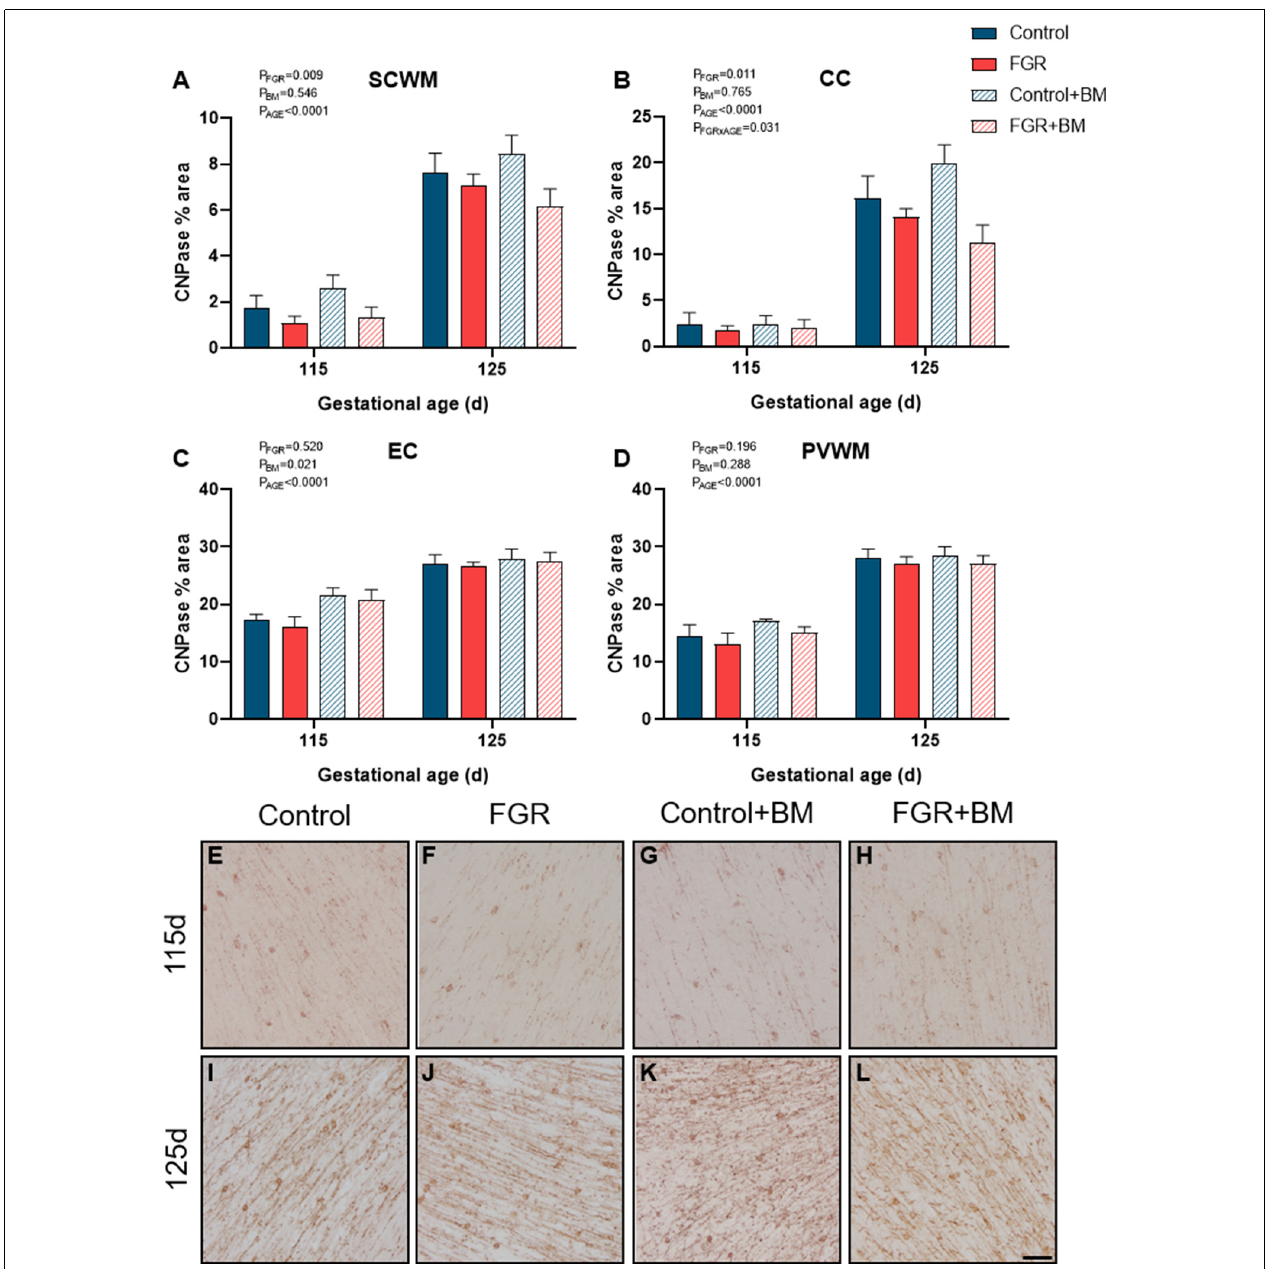
FIGURE 3 | CNPase immunoreactivity. The % area of CNPase positive staining in the SCWM (A) , CC (B) , EC (C) and PVWM (D) and photomicrographs of the SCWM from 115 days control (E) , FGR (F) , control+BM (G) , FGR+BM (H) and 125 days control (I) , FGR (J) , control+BM (K) and FGR+BM (L) fetuses. Data are presented as mean ± SEM, scale bar = 50 µ